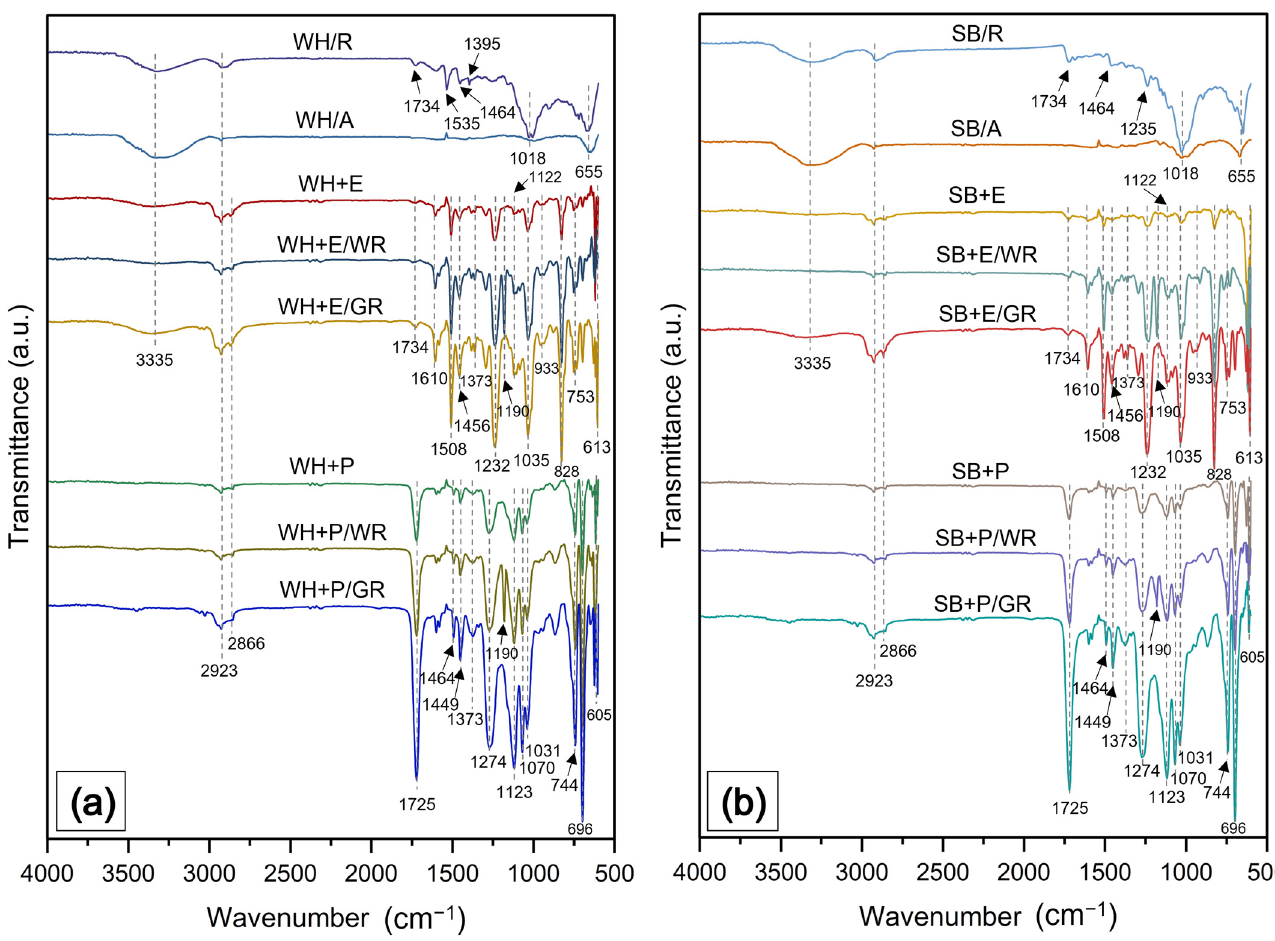
Figure 5. ( a ) FTIR spectrum of standard (WH + E, WH + P), water-repellent-treated (WH + E/WR, WH + P/WR) and gamma-irradiated (WH + E/GR, WH + P/GR) water hyacinth composites, and ( b ) EDX spectrum of standard (SB + E, SB + P), alkali-treated (SB + E/WR, SB + P/WR) and gamma- irradiated (SB + E/GR, SB + P/GR) sugarcane bagasse composites.